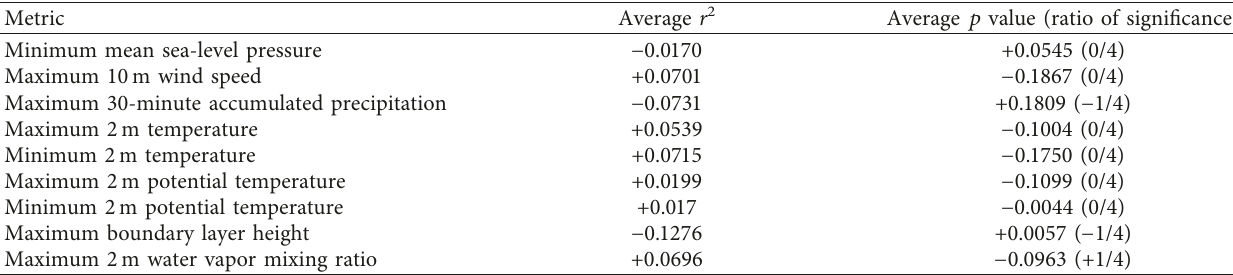
Table 6: Difference between the wind farm ensemble and stratospheric temperature perturbation ensemble in the average coefficient of determination ( r 2 ), average p value, and the ratio of significant cases for perturbations to tropical